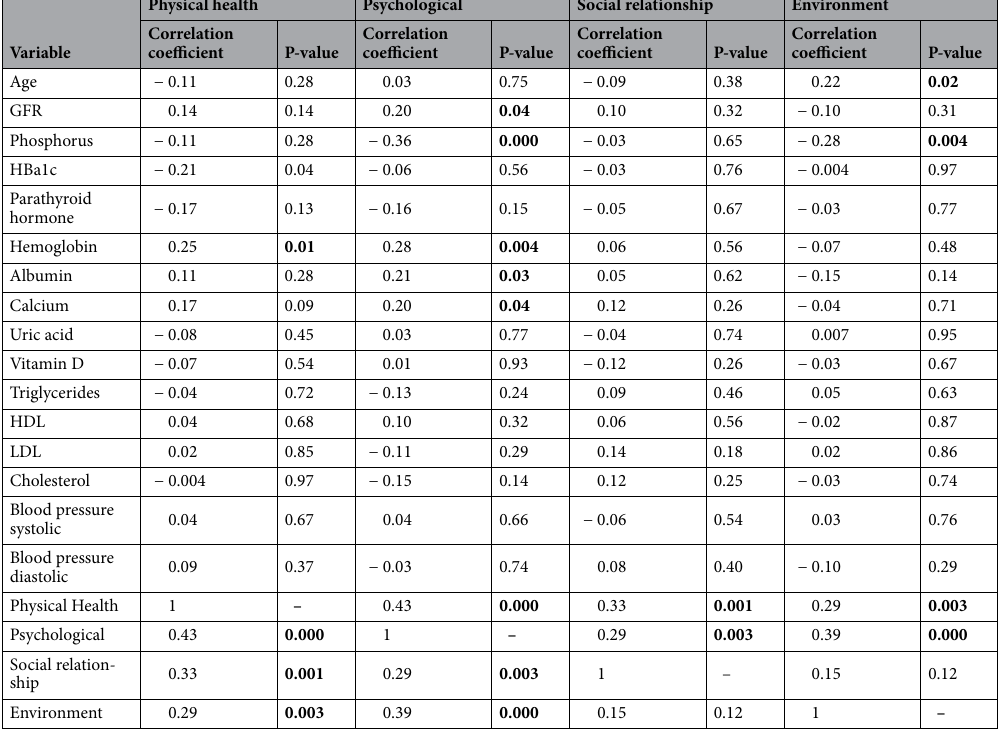
Table 6. QOL domains and correlation with laboratory and clinical data. Significant values are in